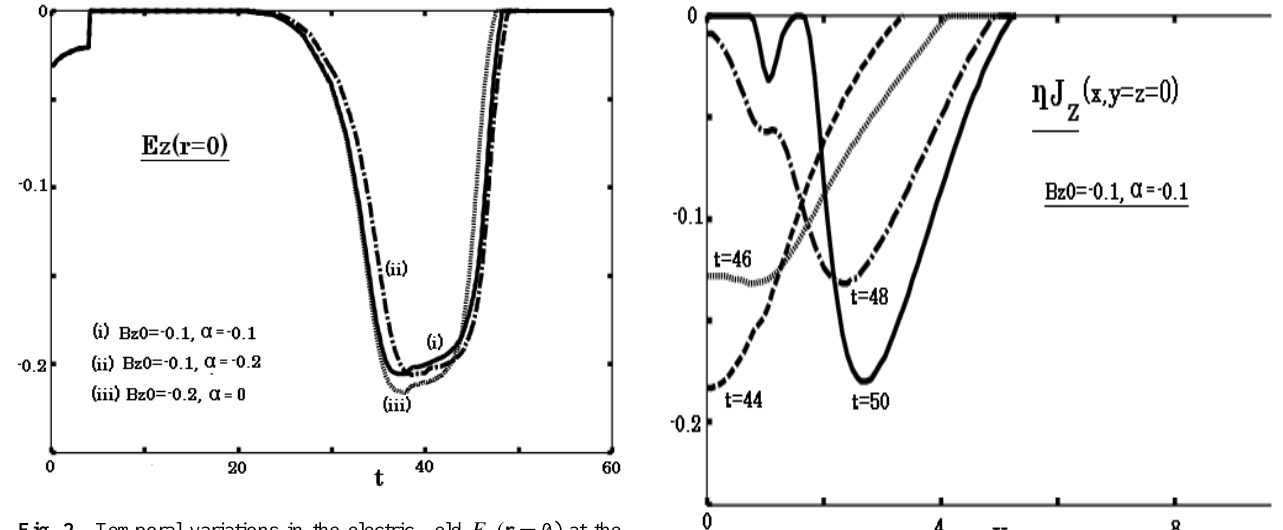
Figure 5: Distributions of plasma pressure P with the contour interval of 0 : 15 in the z = 0 plane at difierent times for the case of B